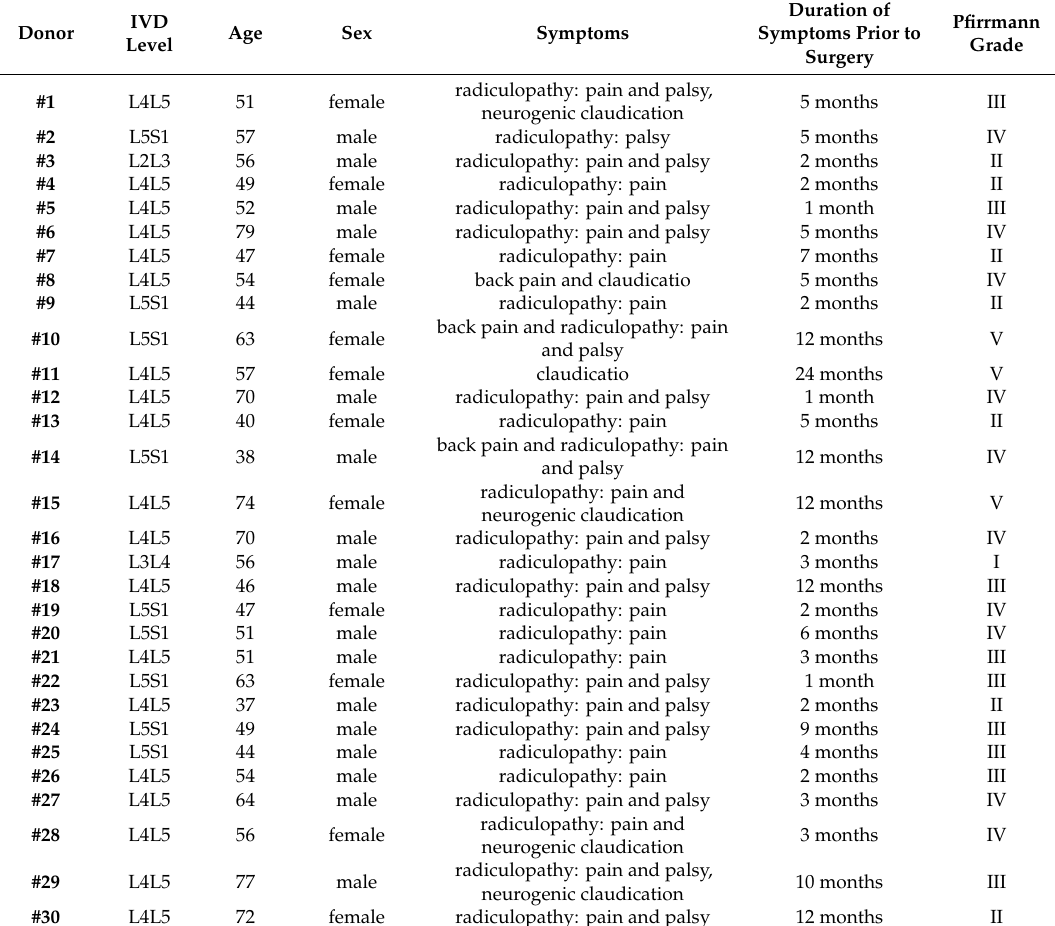
Table 1. Human intervertebral disc (IVD) samples